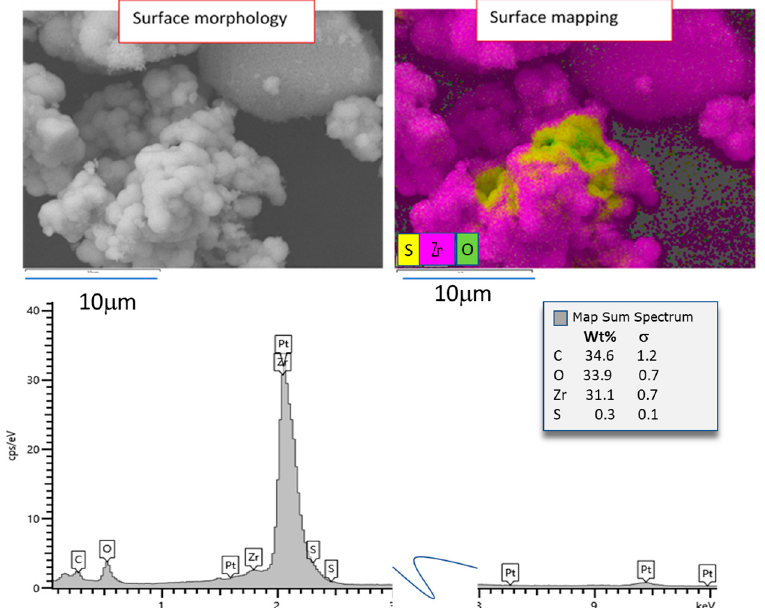
Figure 4. Chemical analysis of example ZrO2_PS sample using EDS mapping (detected C is back- ground from mounting carbon tape, Pt is conductive coating) .